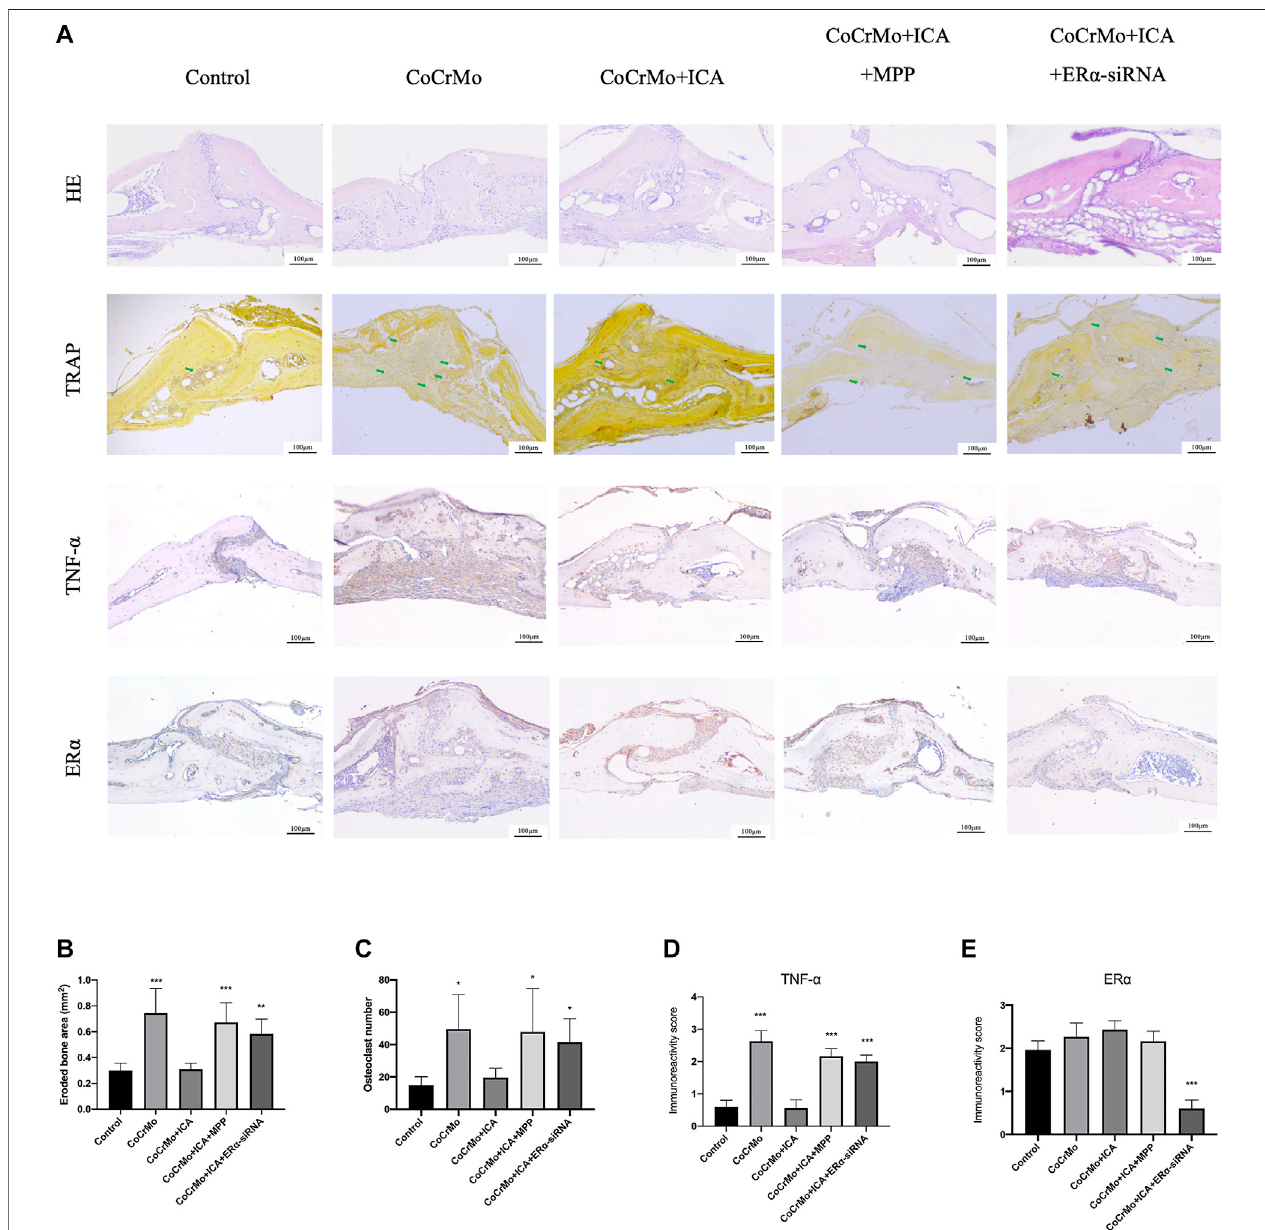
FIGURE 6 | The protective effect of ICA on CoCrMo particle-induced osteolysis and local in fl ammatory in fi ltration in mouse calvaria was regulated by ER α . (A) Representative histologicalslideimages of HE, TRAP, TNF- α , and ER α staining for each group at 10xmagni fi cation. The green arrows indicate osteoclasts. Quantitative measurements were obtained by calculating the eroded bone area (B) , TRAP-positive cell number (C) , TNF- α staining intensity (D) , and ER α staining intensity (E) . * indicates p < 0.05, ** indicates p < 0.01, and *** indicates p < 0.001. There were fi ve C57BL/6J mice in each group.